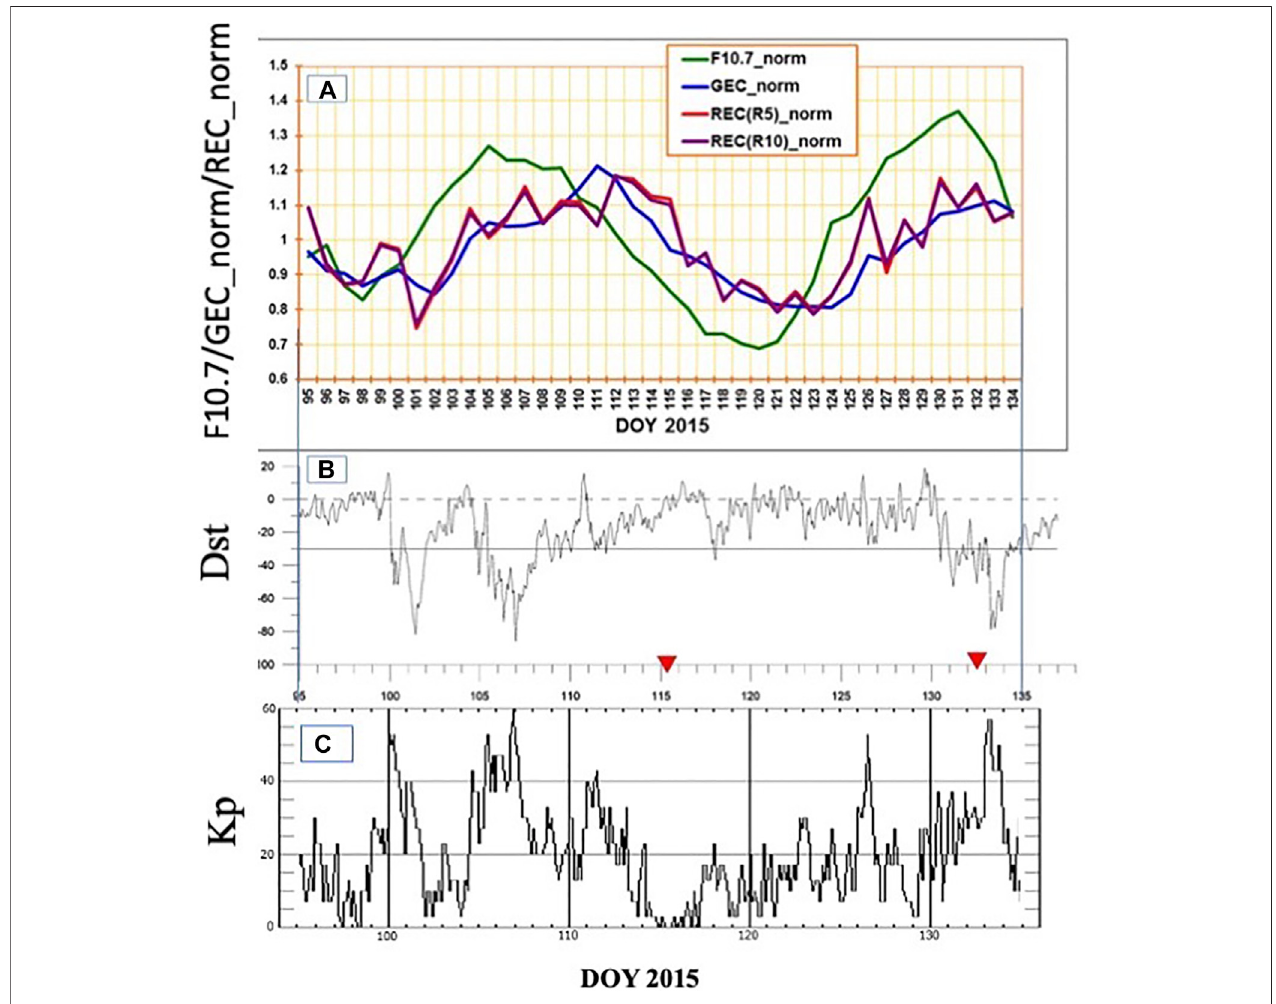
FIGURE 7 | Solar-geophysical conditions during April − May 2015. Al Normalized values of: FI0.7 — Solar electromagnetic radiation on the Wavelength 10.7 cm; GEC — Global ionospheric content, sum of all values in the IONEX table; REC (R5) — the Regional Ionospheric Content — within the 500 km radius circle; REC (RIO) — it is the Regional Ionospheric Content — Within the 1000 km radius circle; 8/ Dst equatorial geomagnetic index; Cl Planetary K-index (Kp* l 0, OMNI WEB Plus).